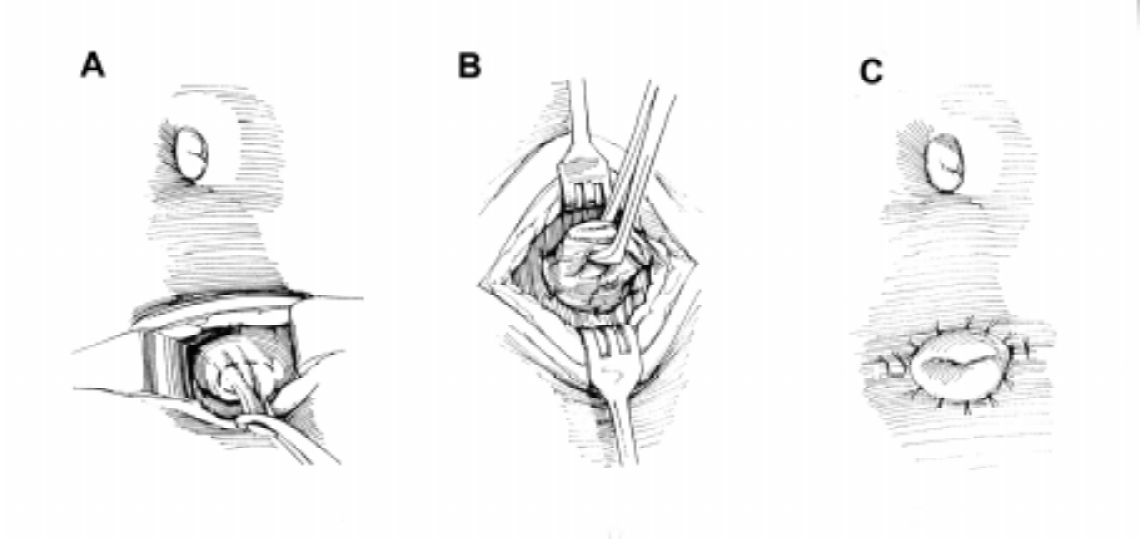
Figure 1 - Blocksom vesicostomy. A) The skin, rectus fascia, and muscle are divided. The urachus is identified and pulled into the wound. B) and C) The urachus is excised, the posterior and anterior serosa of the bladder are approximated to the rectus fascia, and the bladder mucosa is approximated to the skin. (From Hinman F Jr: Atlas of Pediatric Urology. Philadelphia, W.B. Saunders Co., 1994, with